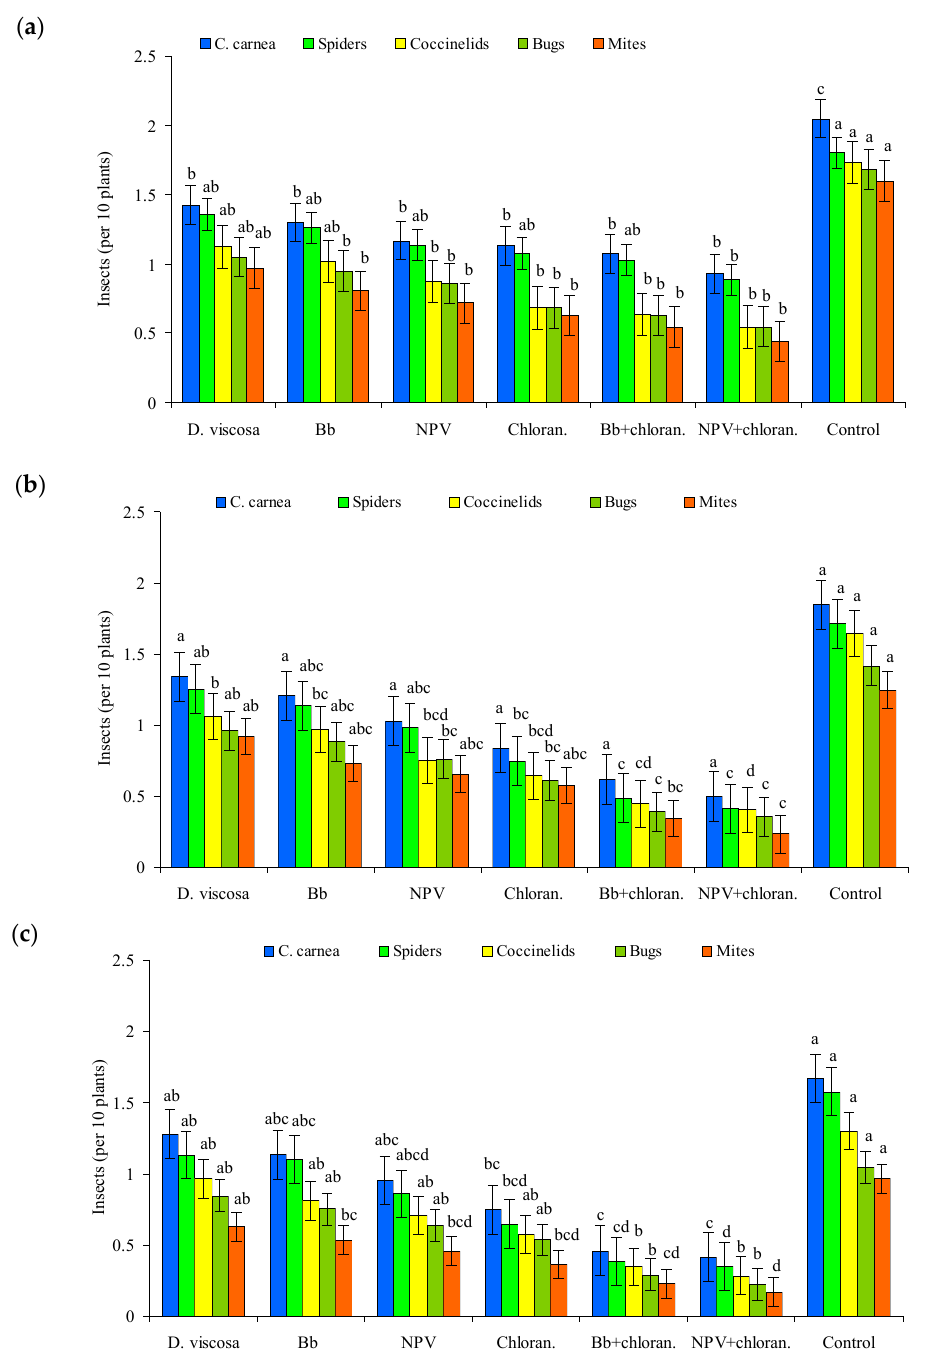
Figure 1. Population density (mean number per ten plants ± SE) of natural enemies following field application of different biorational and chemical control options based on B. bassiana ; HaNPV; D. viscosa and chlorantraniliprole (chloran.) at ( a ) 3 DAT, ( b ) 5 DAT and ( c ) 7 DAT after the second spray at Rawalpindi. Means followed by the same letters are not significantly different from each other within each sample time and for each natural enemy taxon; Tukey-Kramer HSD test at p = 0.05.